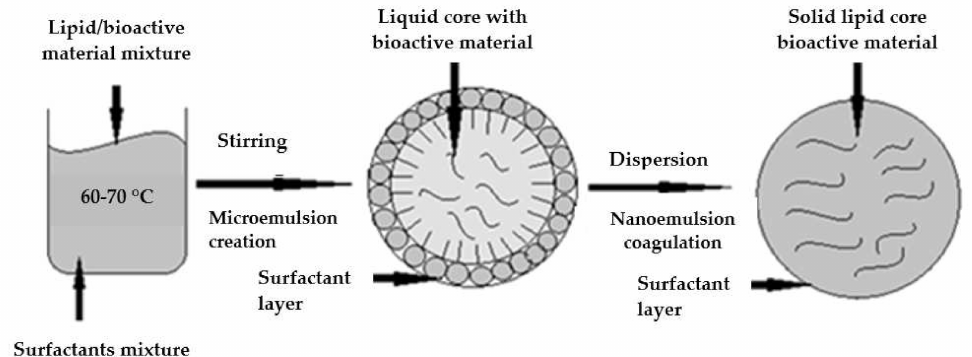
Figure 6. Structures formed by microemulsion fabrication of lipid nanoparticles (modified from [1]; original paper under the terms of the Creative Commons CC BY-NC